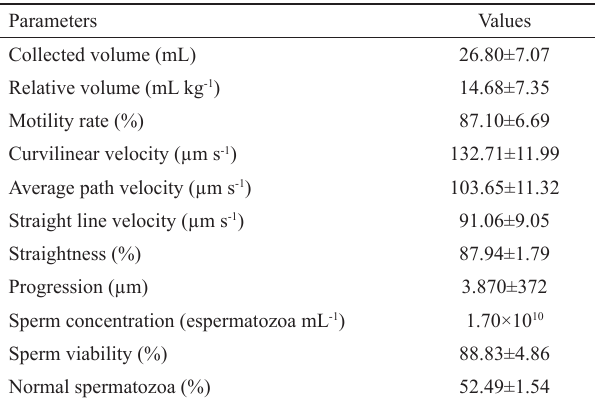
Table 2. Semen and sperm parameters in Steindachneridion parahybae (mean±standard